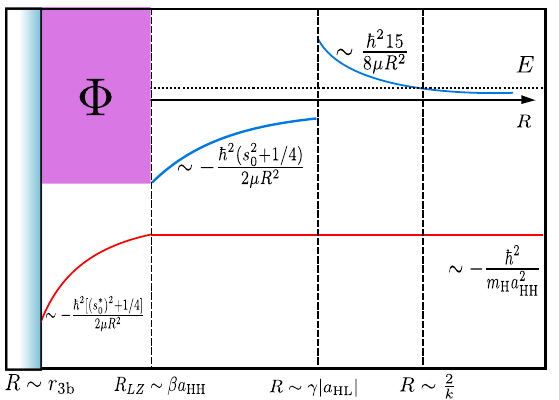
Figure 5. An illustration of the approximate hyperspherical potential curves shown in Figure 1, where s 0 and s ∗ 0 are the universal Efimov scaling coefficients. These piecewise curves are used in Equations (12), (13) and